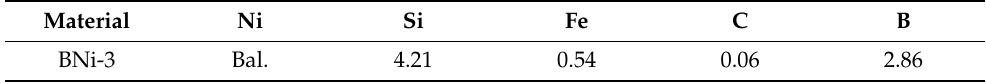
Table 2. Chemical composition of nickel-based BNi-3 amorphous foil (wt.%).